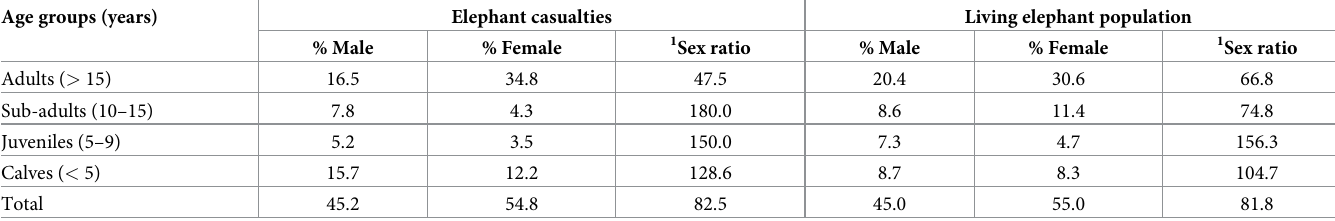
Table 5. The sex ratios of age specific elephant casualties from train collisions (1990–2018) and living elephant population (2017) in Assam.